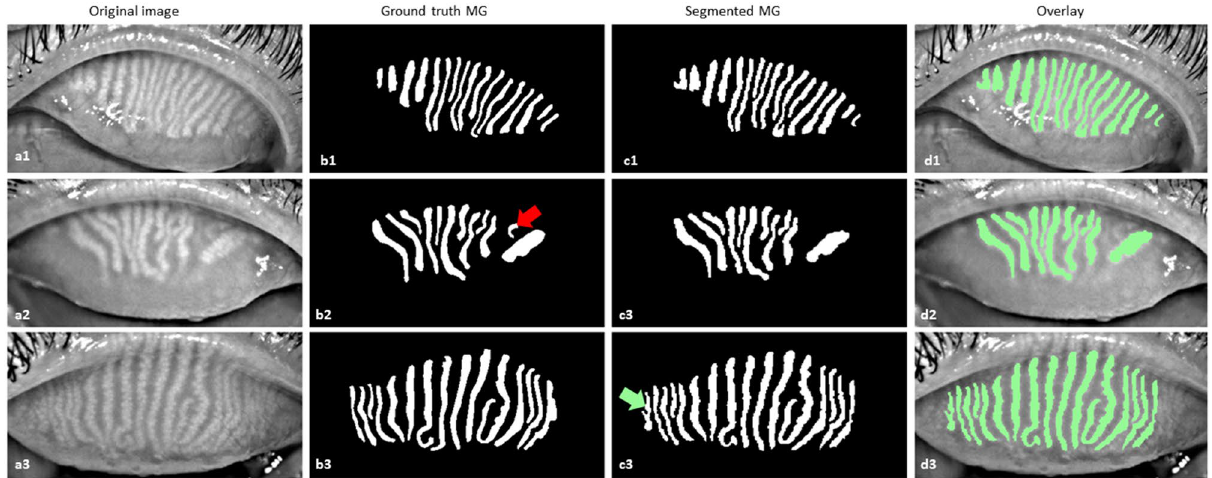
Figure 3. Example of MG segmentation from upper eyelid on test images. ( a1 – a3 ) Original images, ( b1 – b3 ) ground truth MG, ( c1 – c3 ) segmented MG, and ( d1 – d3 ) overlay of the original image and segmented MG. The red ( b2 ) and green ( c3 ) arrows indicate the missing gland and false gland segmentation respectively.